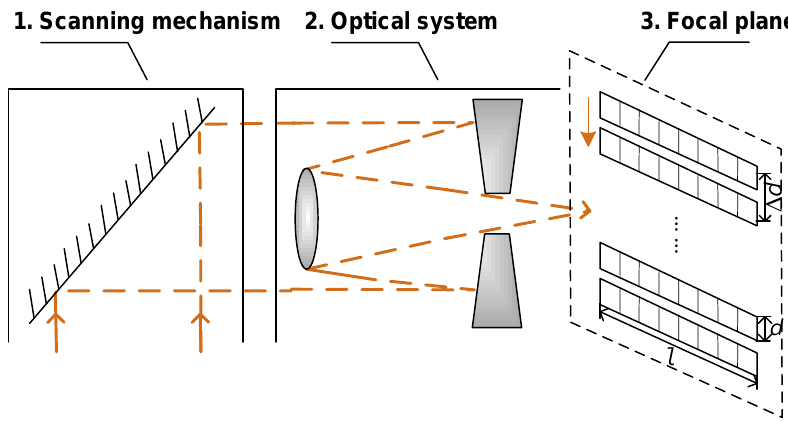
Figure 2. The optical path of a double linear array